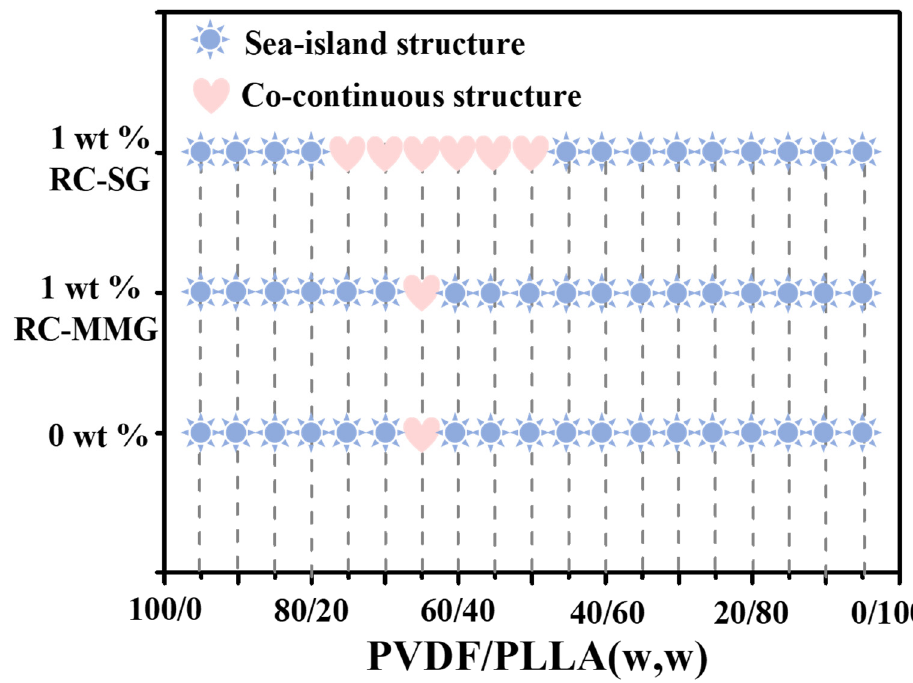
Figure 3. Co-continuous structure of PVDF/PLLA blends as functions of the compositions with and without compatibilizers.